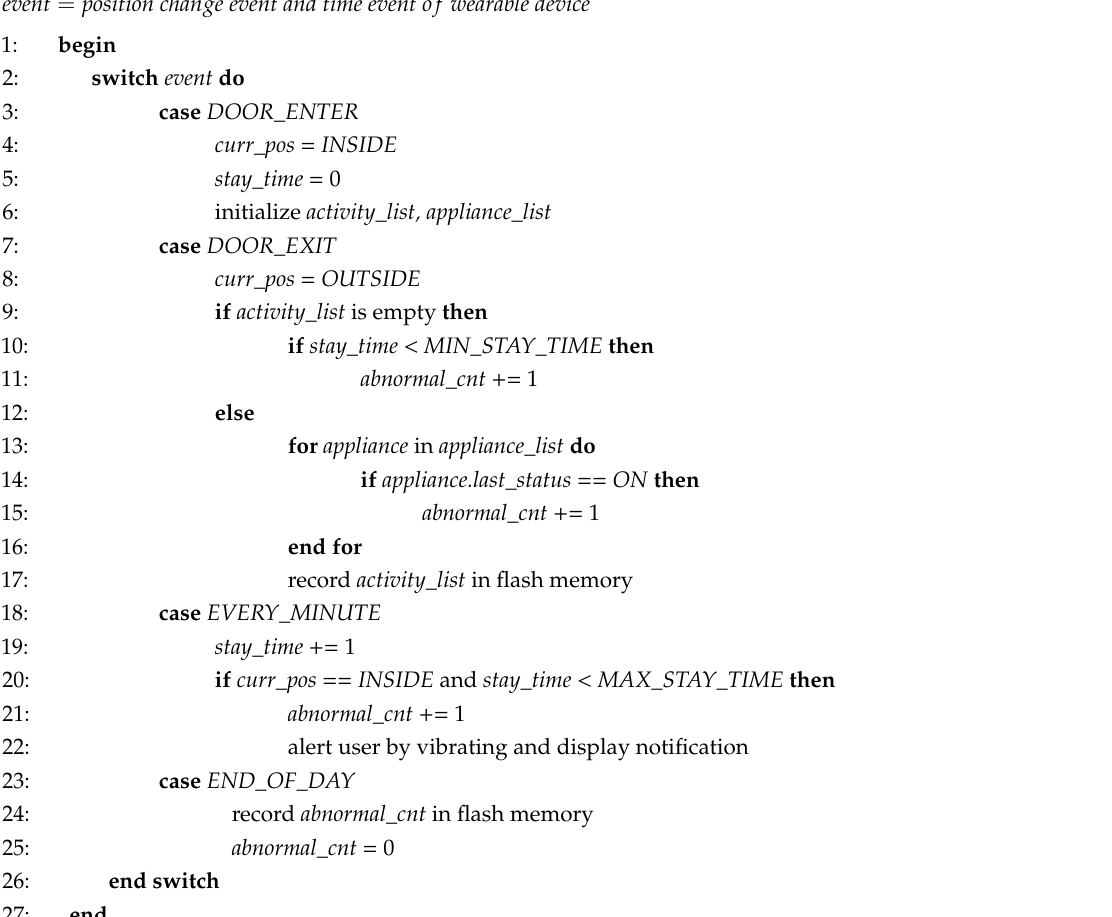
Algorithm 1. Pseudo code for abnormal activity